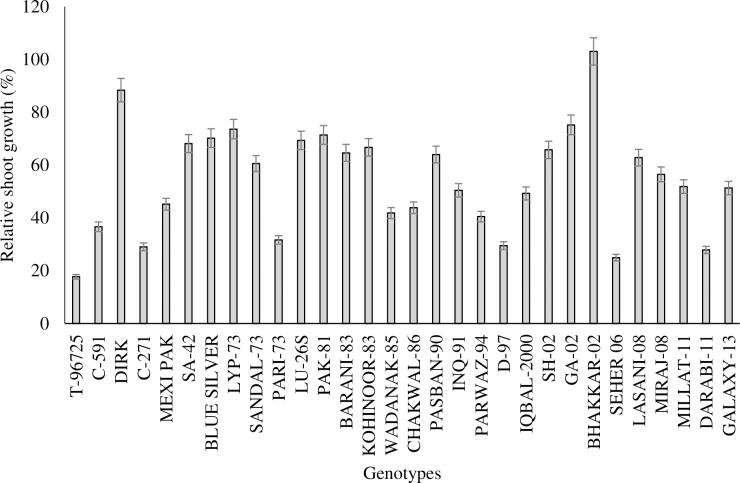
Shoot growth of thirty wheat genotypes grown under P-deficit condition relative to growth at adequate P supply.Bars overlapping with each other do not differ from each other and data are shown as means ± SE of four replicates.